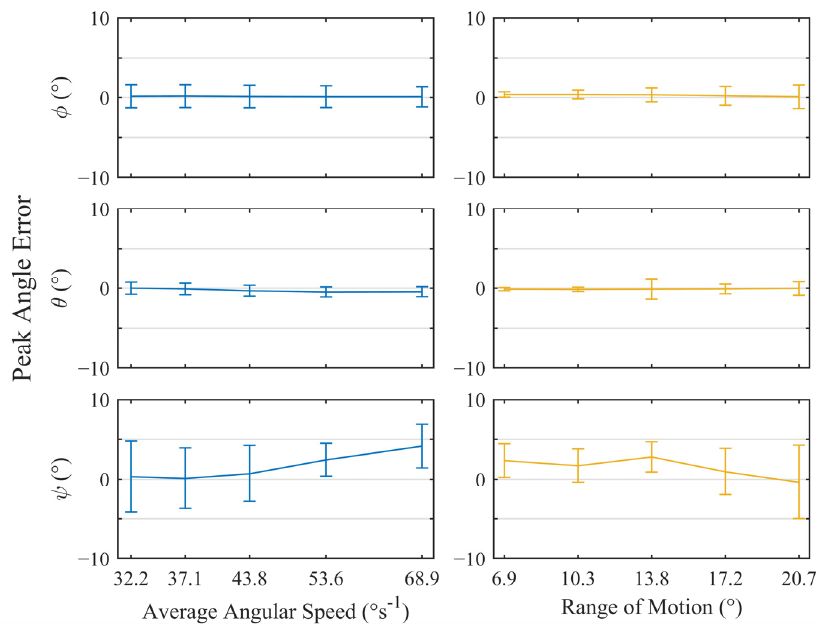
Figure 9. Plots of the mean angular error ± standard deviation for all peaks across n = 5 trackers